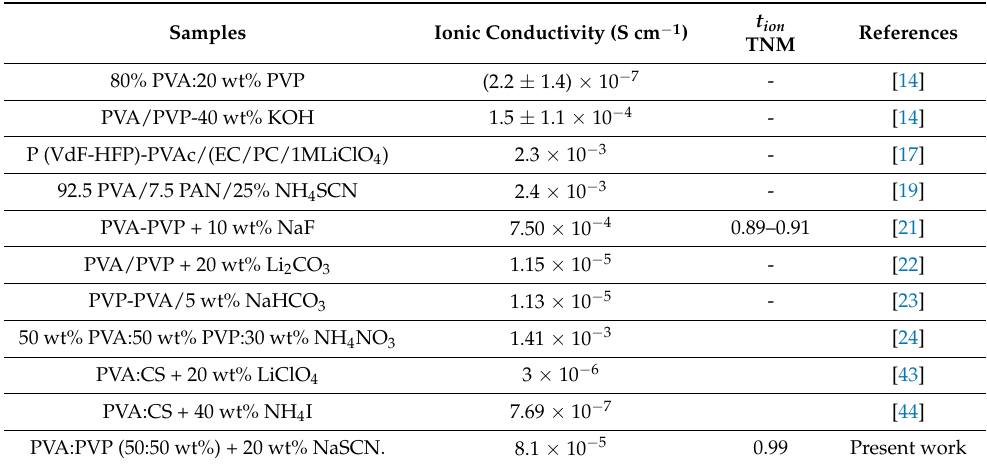
Table 5. Summary of the ionic conductivities and t ion values for some recent solid electrolyte systems and the optimized solid flexible polymer electrolyte (PVA: PVP + 20 wt% NaSCN) prepared in this